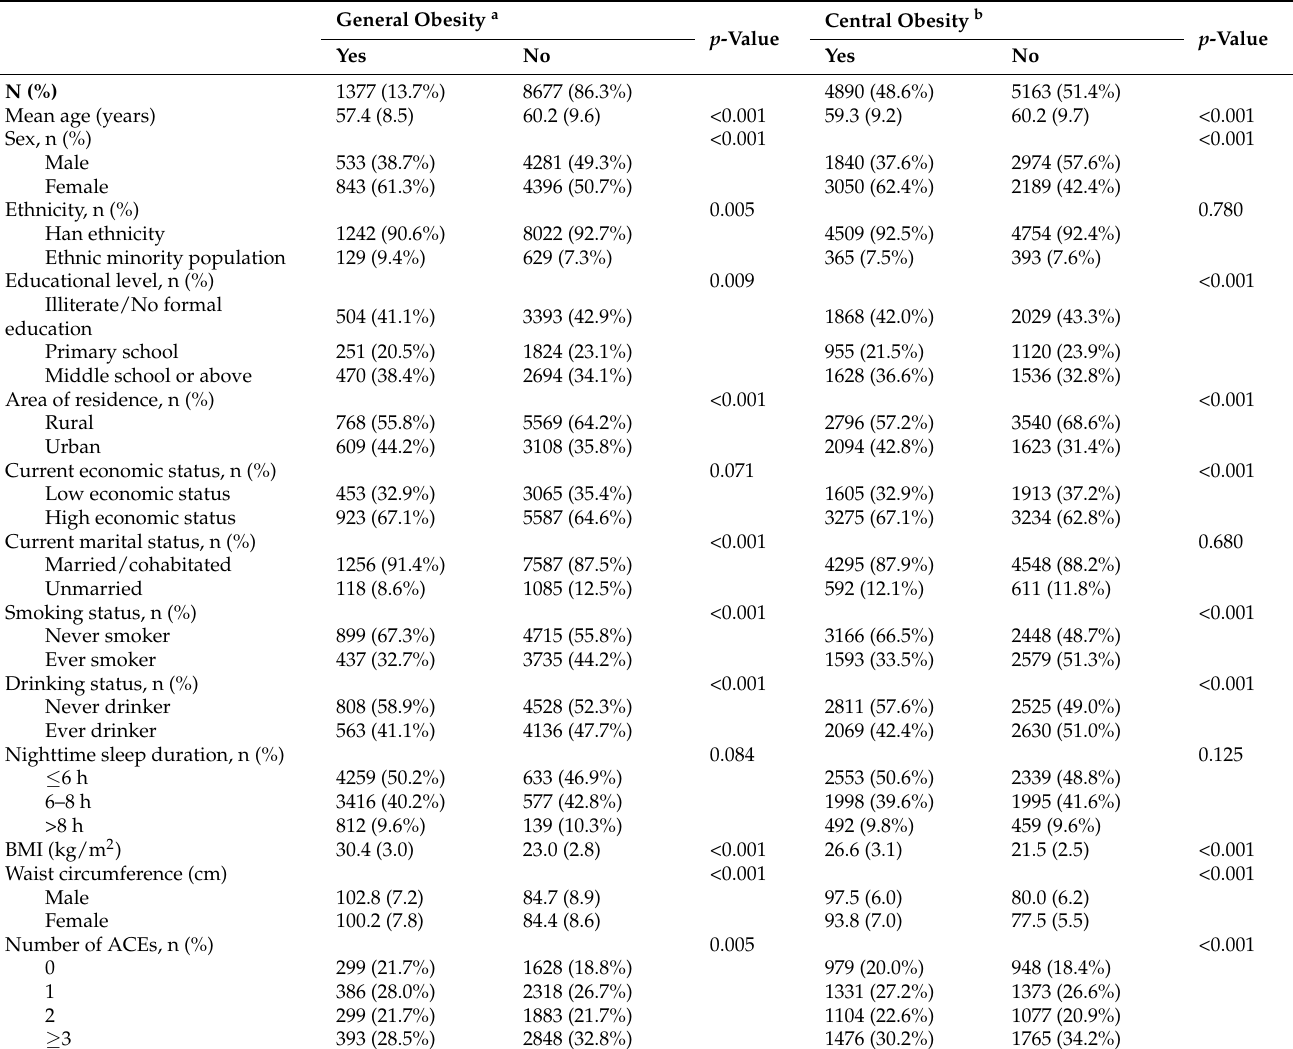
Table 1. Comparison of characteristics by status of general and central obesity in 2015 CHARLS